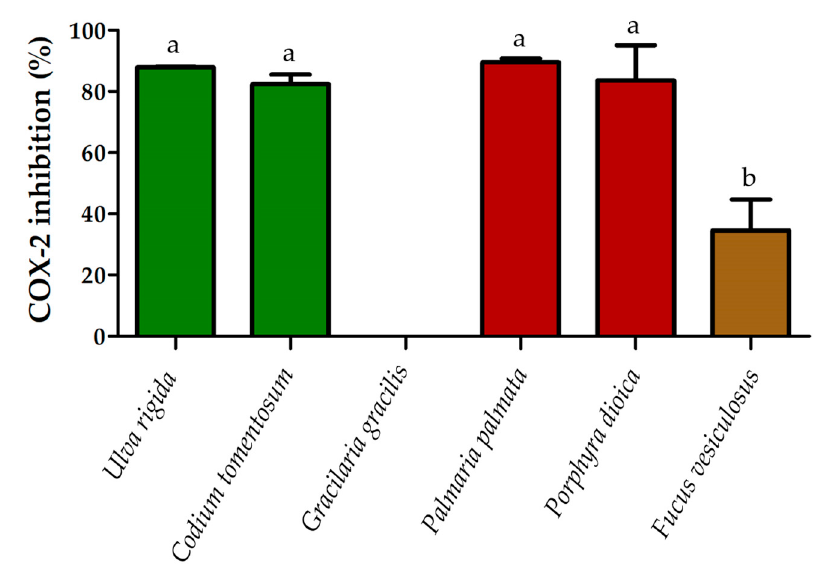
Figure 1. Inhibition of COX-2 activity (expressed in percentage, %) demonstrated by the lipid extracts of Ulva rigida , Codium tomentosum , Palmaria palmata , Porphyra dioica and Fucus vesiculosus at a concentration of 500 μ g/mL. Values are averages of three assays ( n = 3) ± standard deviation. In the case of Gracilaria gracilis , no inhibition was obtained. Different letters indicate significant differences between species ( p < 0.05, ANOVA followed by Tukey’s HSD post hoc analysis). The highest percent of inhibition of COX-2 activity was recorded for the lipid extracts of P.